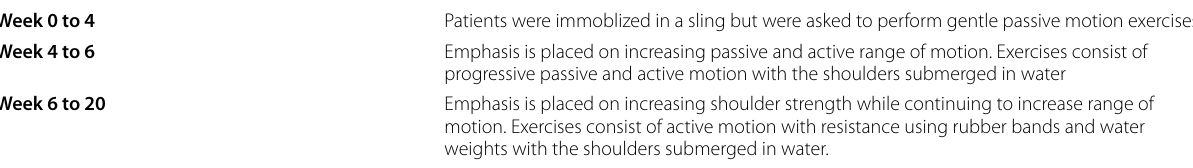
Table 1 Aquatic therapy exercises Week 0 to